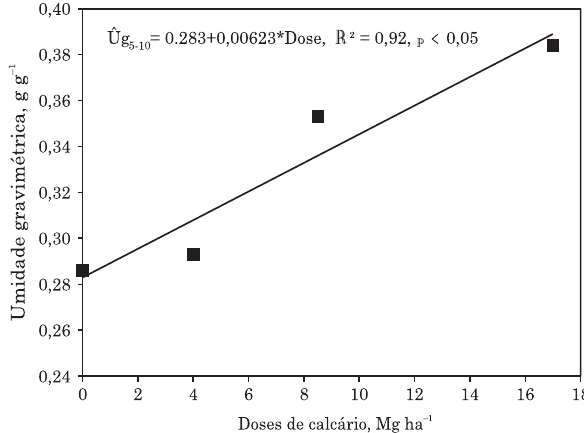
Figura 2. Relação entre a umidade gravimétrica na máxima retenção de água no ensaio de ascensão capilar de acordo com as doses de calcário aplicadas em um Argissolo, camada de 0-5 cm.